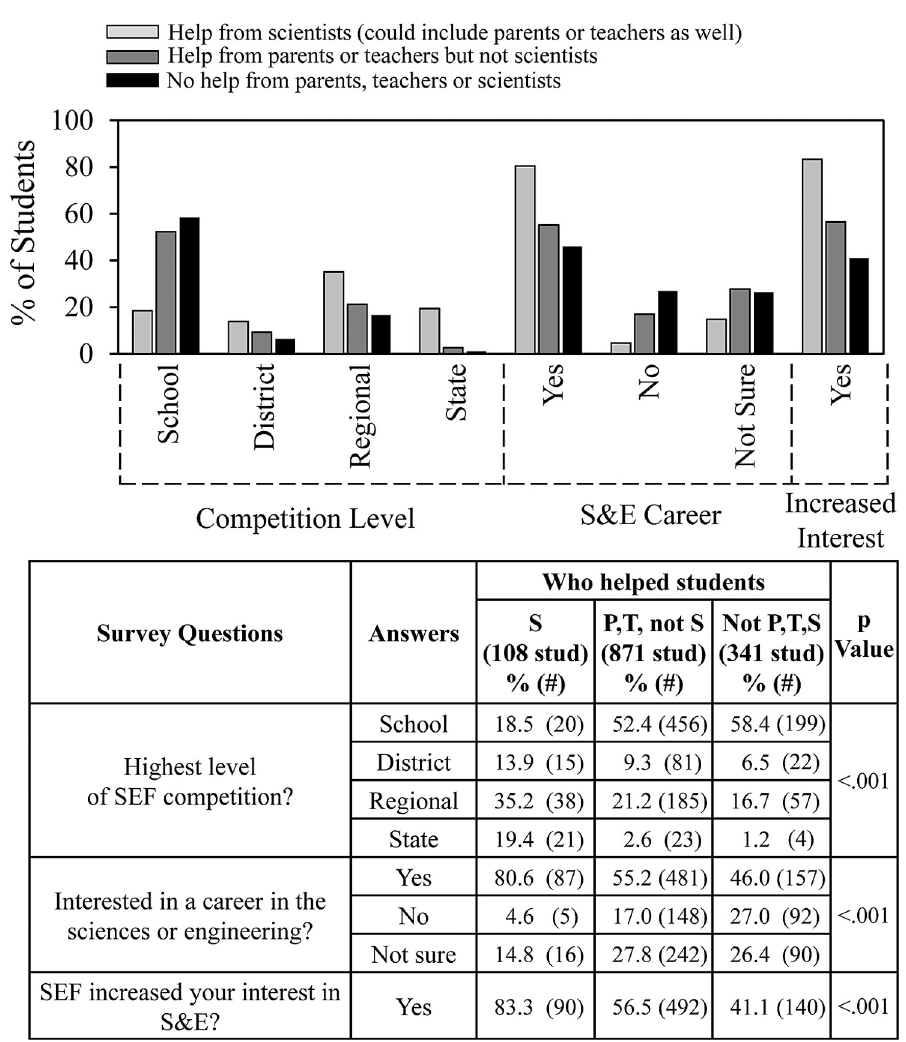
Fig 5. Impact of help from scientists, parents and